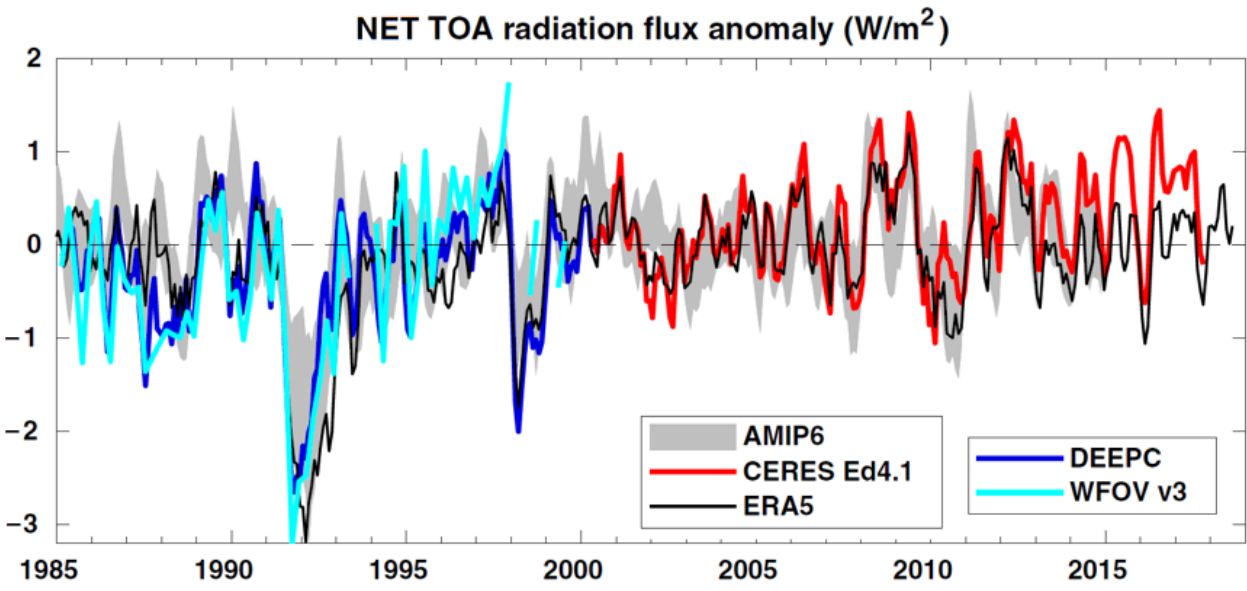
Figure 2. Anomaly time series of the monthly global mean net TOA radiation fluxes (NET) in Wm − 2 . The reference period for anomaly calculation is 2001–2005. All lines are three-month running means. The WFOV data are 72 day means, and their anomalies are calculated with the reference period of 1985–1999. The WFOV line is shifted 0.23 Wm − 2 downward for clarity. Gray shading denotes the ± one standard deviation from ten AMIP6 simulations.